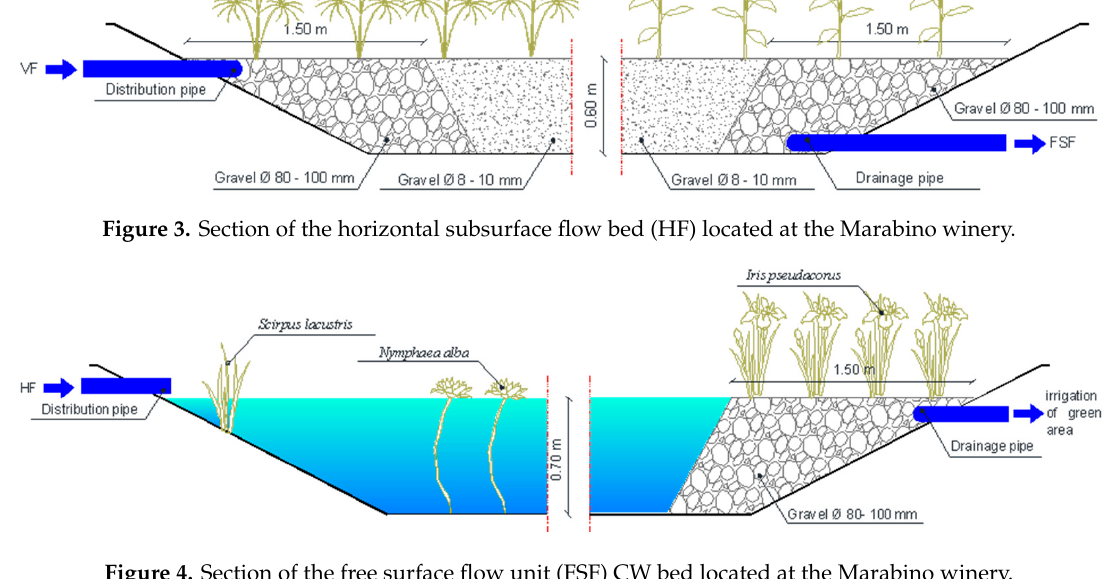
Figure 3. Section of the horizontal subsurface flow bed (HF) located at the Marabino winery.